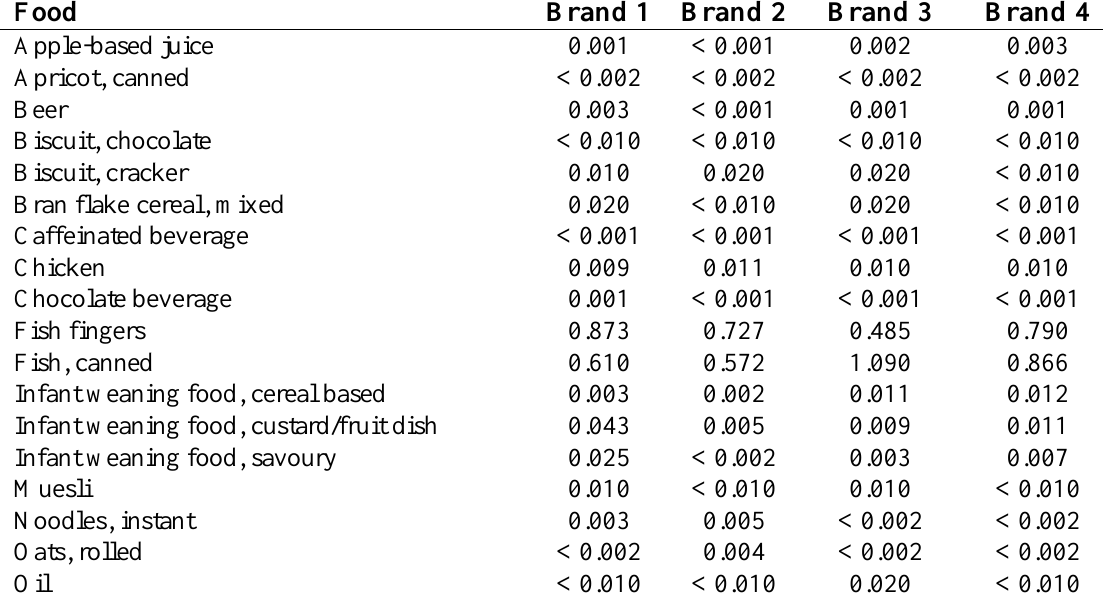
Table 3. Total arsenic content (mg/kg) of selected foods from a study in New Zealand a